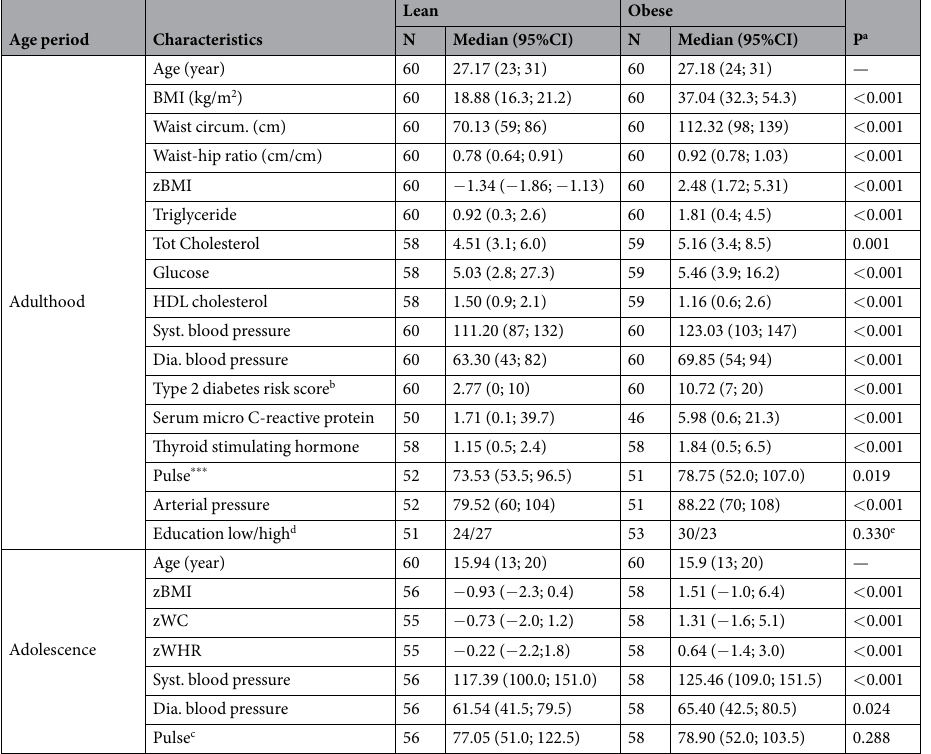
Table 1. Descriptive characteristics. a P-value asymptotic. Sig. (2-tailed) deduced from the Mann-Whitney attendance, High > 14 years school